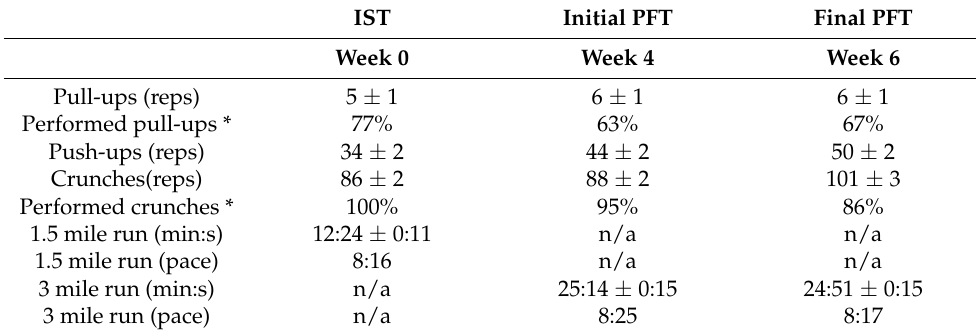
Table 2. Initial strength test and physical fitness test raw scores.